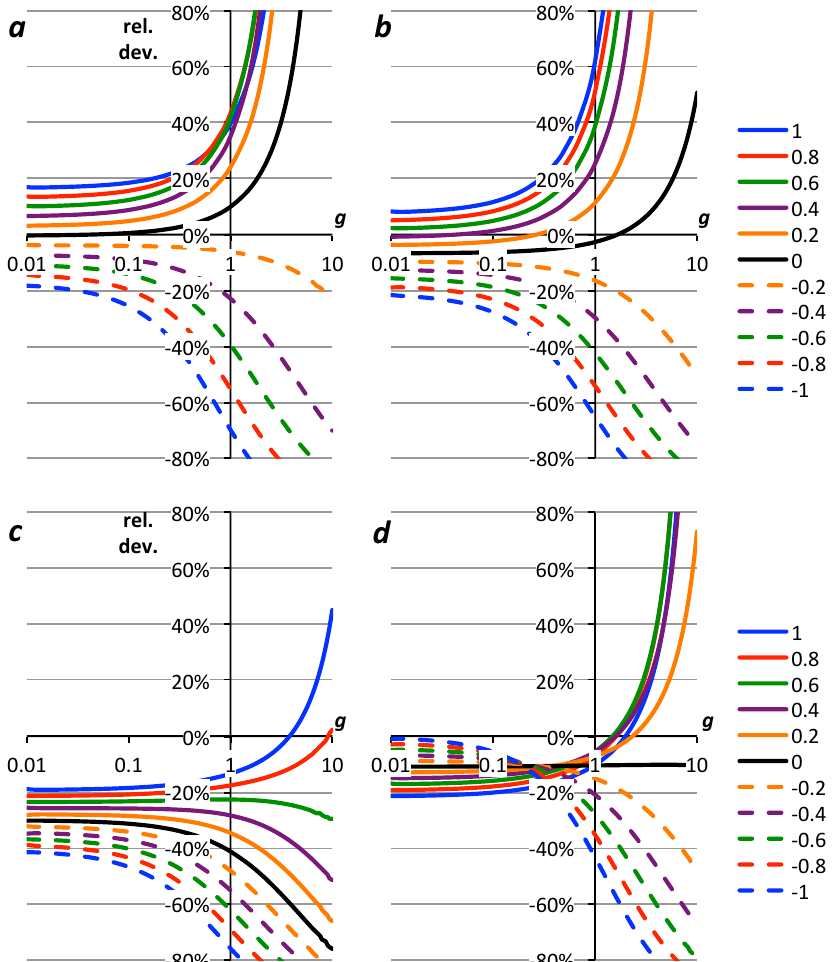
Fig. 2. Relative deviation of the approximated solution for g (Eq. 10) from the accurate solution (Eq. 1) for the parameters in Table 3, row 1 (Kaiser,